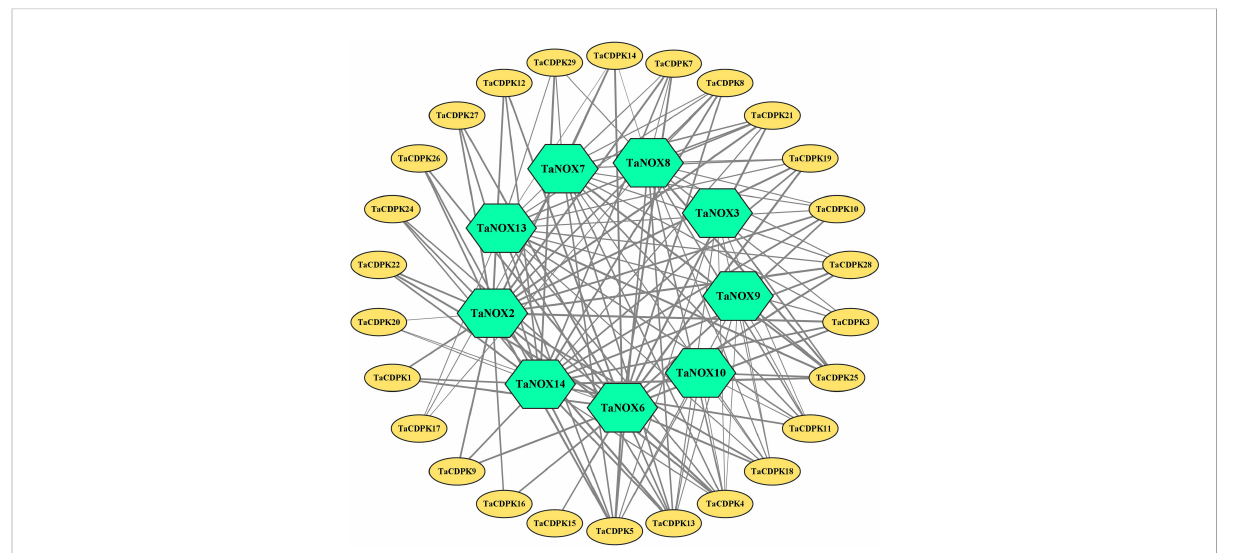
FIGURE 3 The signal network relationships between the members of CDPK and NOX family. The network signal relationships between the members of CDPK family and NOX family were preliminarily predicted on STRING (http://string-db.org/cgi/input.pl?sessionId=bdYxf9Fv5NiI&input_page_ show_search=on), and then the network signal diagram between them were also drawn by softwares of TBtools Cytoscape and Adobe Photoshop. The edge(line) width is positively correlated with the combined score in STRING (Min 1- Max